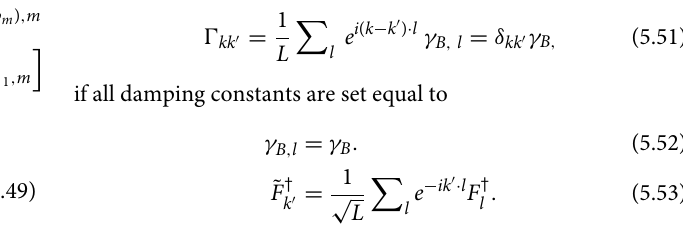
FIGURE 8 | Damped temporal curves representing the real parts of three selected substrate operators (ground states) that are consecutively performed by steps 1–4. The following algebraic